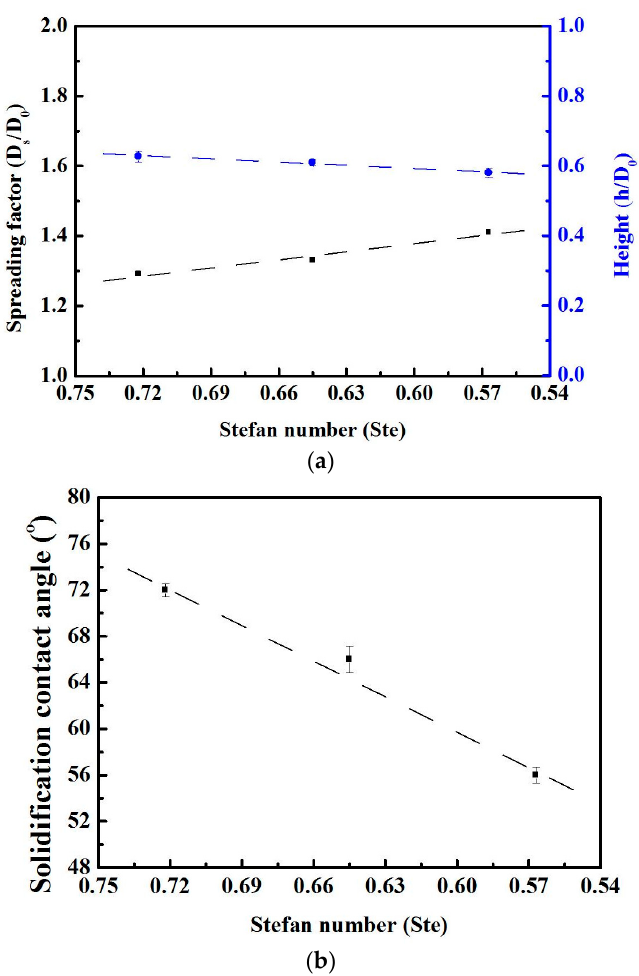
Figure 9. The spreading diameter of a micro metal droplet and the final shape of droplets formed on a gold-plated glass substrate. ( a ) The experimentally determined spread factor and height for the different substrate temperatures (Stefan number); ( b ) the effects of various substrate temperatures on the solidification contact angle of the droplets.